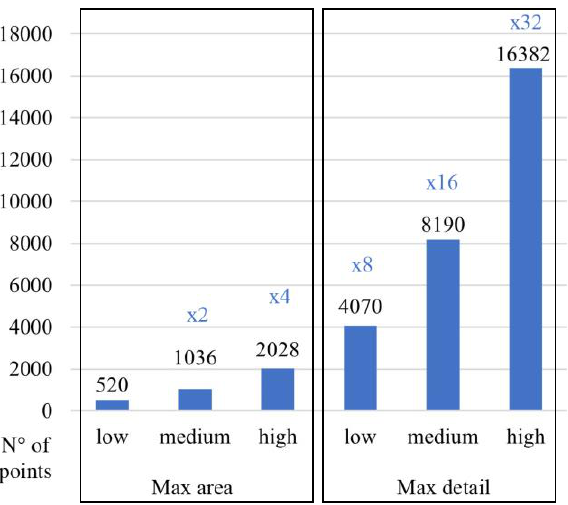
Figure 8 . Portion of the wall where roughness and density are computed on an area of 1 m 2